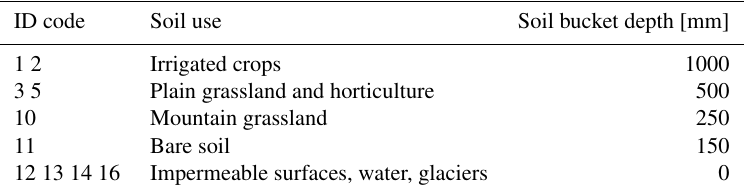
Table 3. Soil bucket depth as a function of land cover class. For trees (codes 4, 6, 7, 8 and 9) the full soil depth from the soil map of the Piemonte Region is used. ID code Soil use Soil bucket depth [mm] 1 2 Irrigated